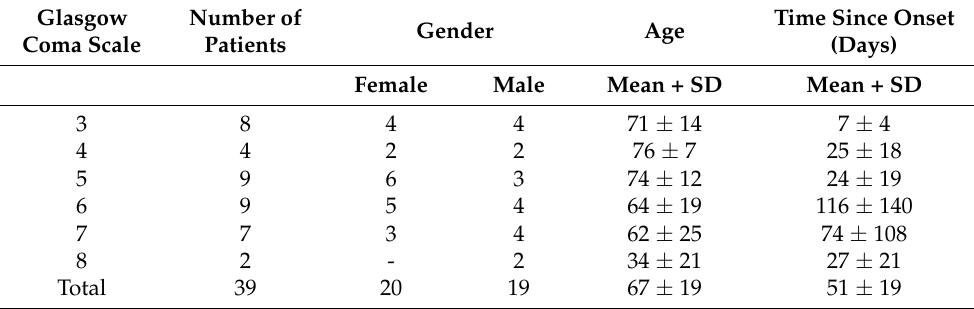
Table 1. Descriptive statistics of patients.